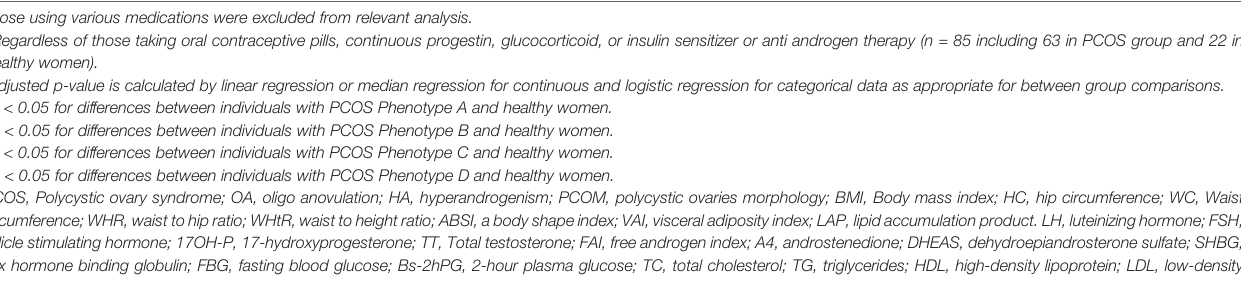
d P < 0.05 for differences between individuals with PCOS Phenotype D and healthy women. PCOS, Polycystic ovary syndrome; OA, oligo anovulation; HA, hyperandrogenism; PCOM, polycystic ovaries morphology; BMI, Body mass index; HC, hip circumference; WC, Waist circumference;WHR,waisttohipratio;WHtR,waisttoheightratio;ABSI,abodyshapeindex;VAI,visceraladiposityindex;LAP,lipidaccumulationproduct.LH,luteinizinghormone;FSH, follicle stimulating hormone; 17OH-P, 17-hydroxyprogesterone; TT, Total testosterone; FAI, free androgen index; A4, androstenedione; DHEAS, dehydroepiandrosterone sulfate; SHBG, sex hormone binding globulin; FBG, fasting blood glucose; Bs-2hPG, 2-hour plasma glucose; TC, total cholesterol; TG, triglycerides; HDL, high-density lipoprotein; LDL, low-density lipoprotein; SBP, systolic blood pressure; DBP, diastolic blood pressure.